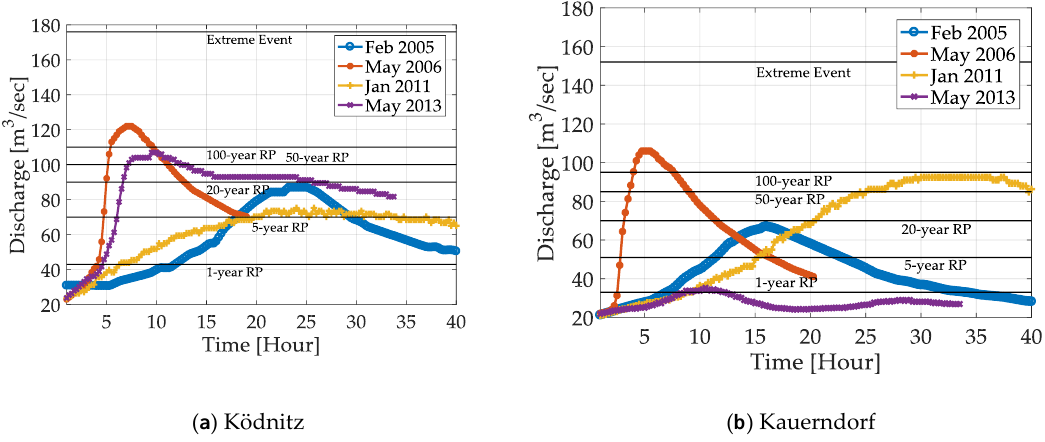
Figure 4. Discharge hydrographs at the upstream gauging stations ( a ) Ködnitz and ( b ) Kauerndorf. Data source: Bavarian Hydrological Service (www.gkd.bayern.de).